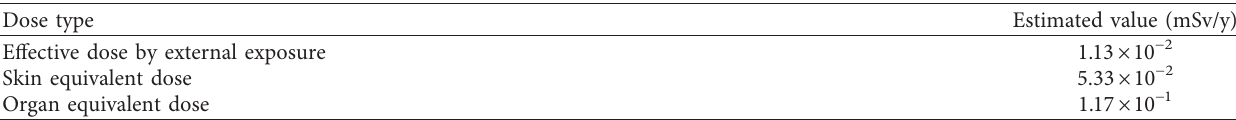
Figure 4: Calculated dose results to each age groups for the (a) nuclear and (b) coal-fired power plant. Table 6: Calculated dose results using